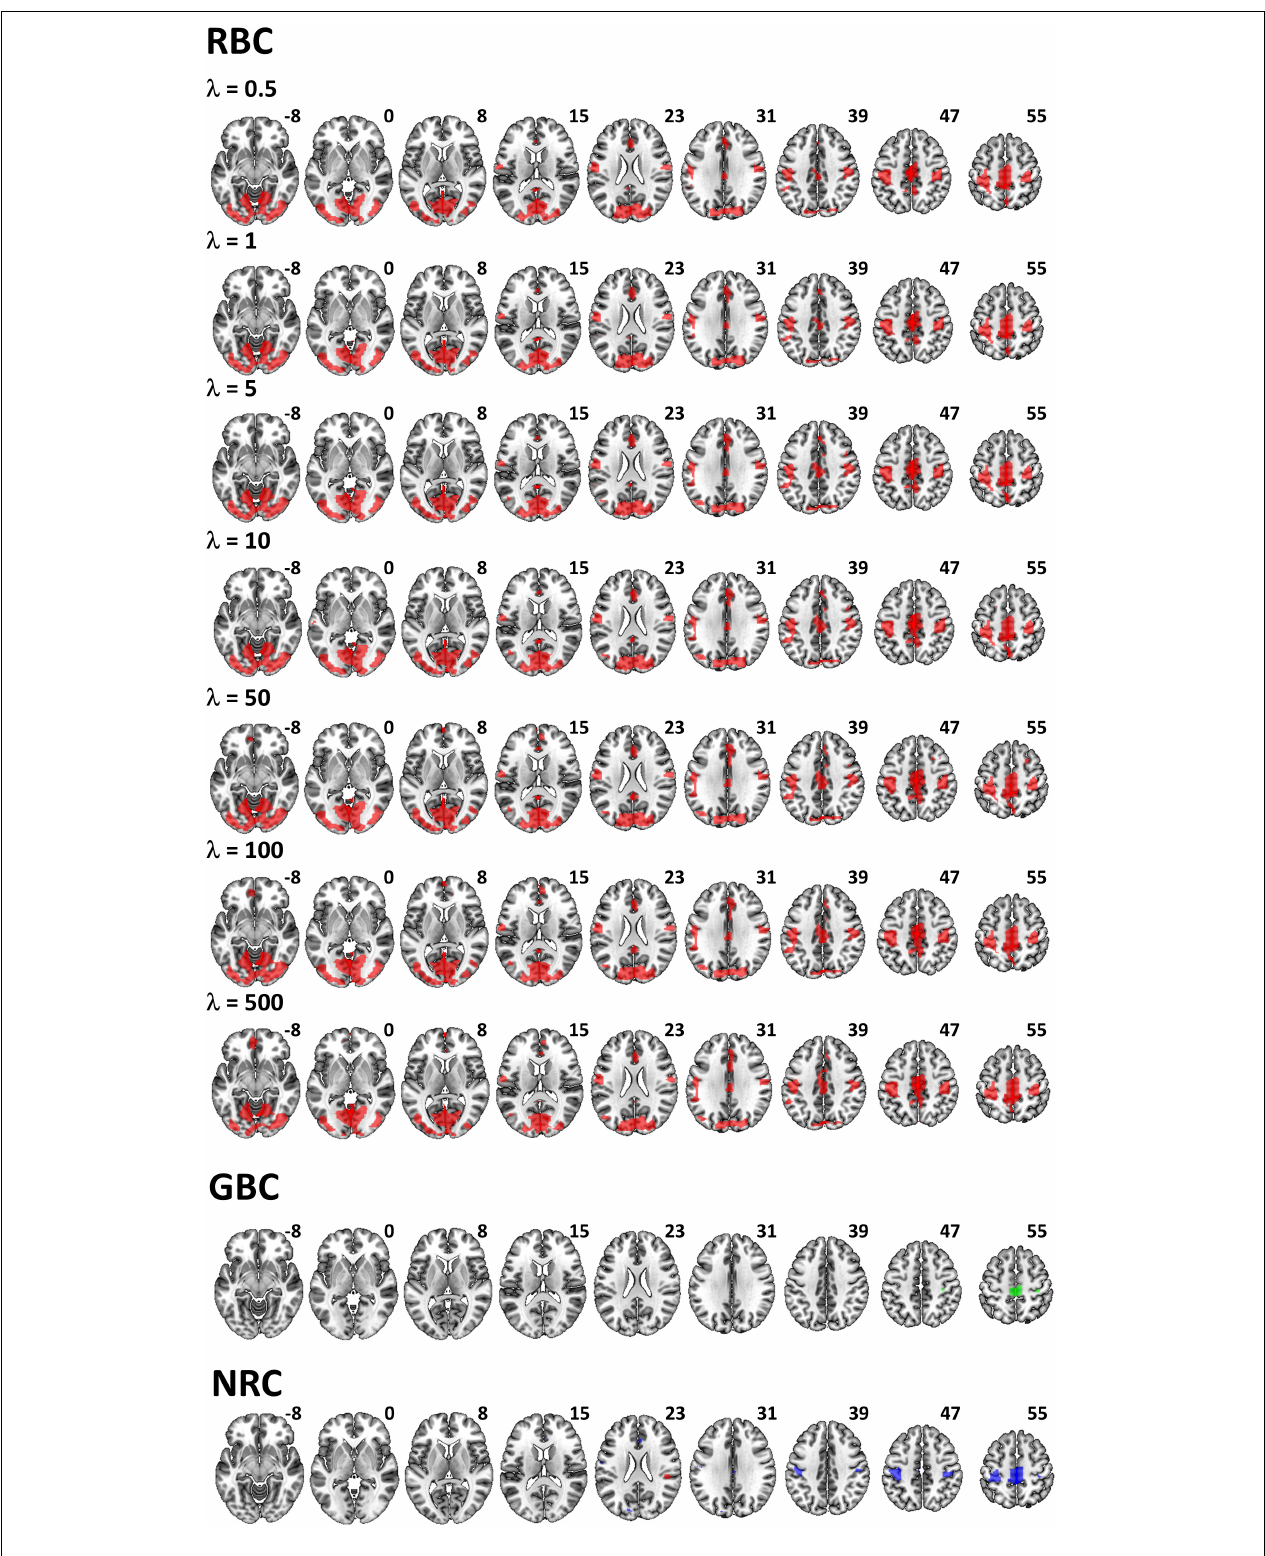
FIGURE 1 | Brain areas with significant differences in RBC, GBC and NRC between patients and healthy controls. RBC results are given for the different regularization values ( λ values) applied in the ridge regressions. While for the RBC (red) and GBC (green), comparisons only included reductions in connectivity, significant disorder related reductions (blue) and increases (red) were observed with the NRC (although the later were of much smaller extent).